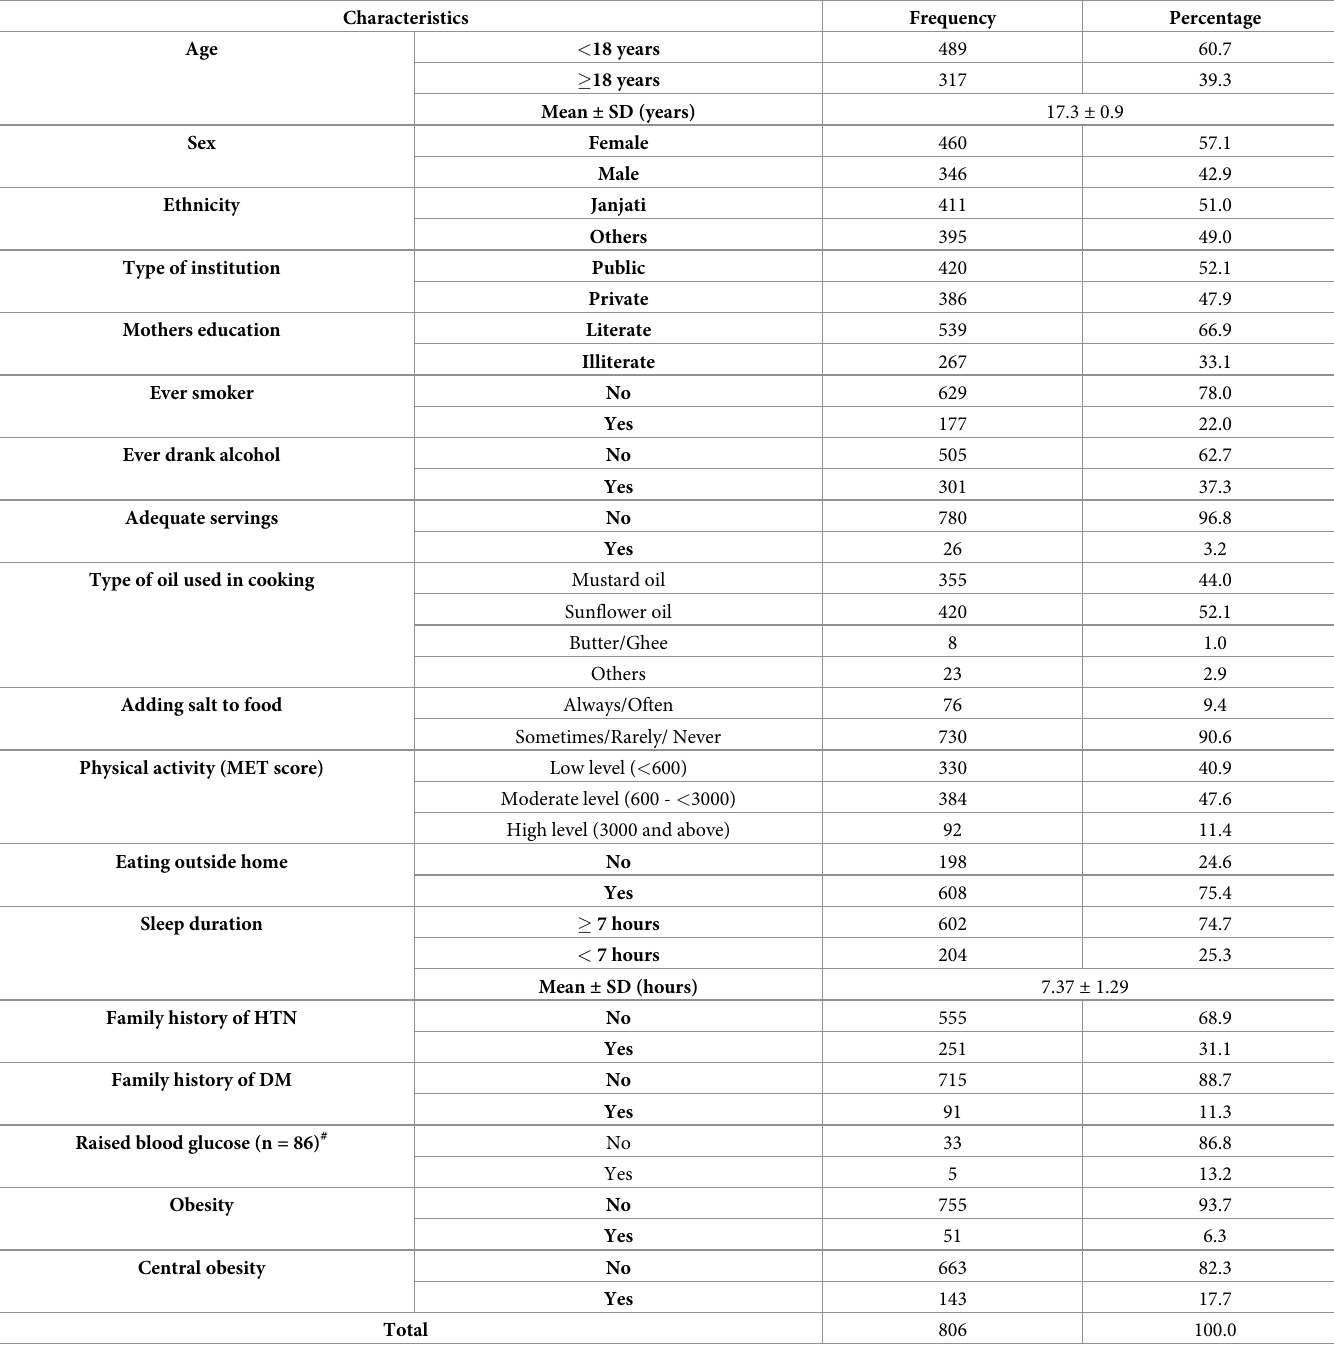
Table 2. Distribution of sociodemographic factors and risk factors among the participants (n =